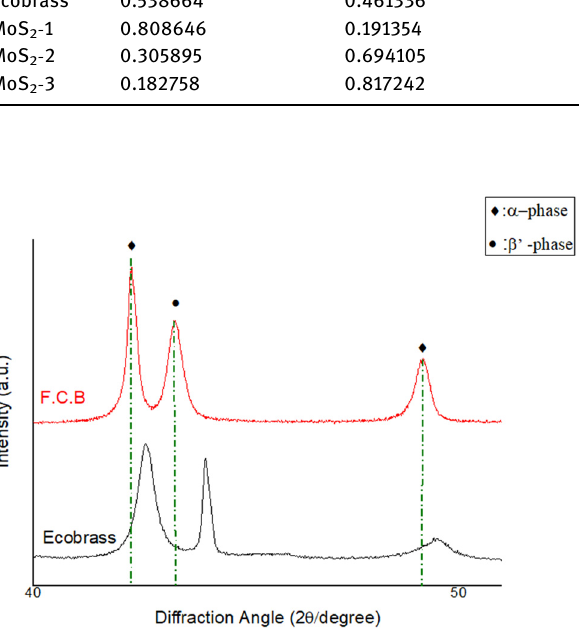
Figure 2: XRD patterns comparison of samples F.C.B and Ecobrass with narrow